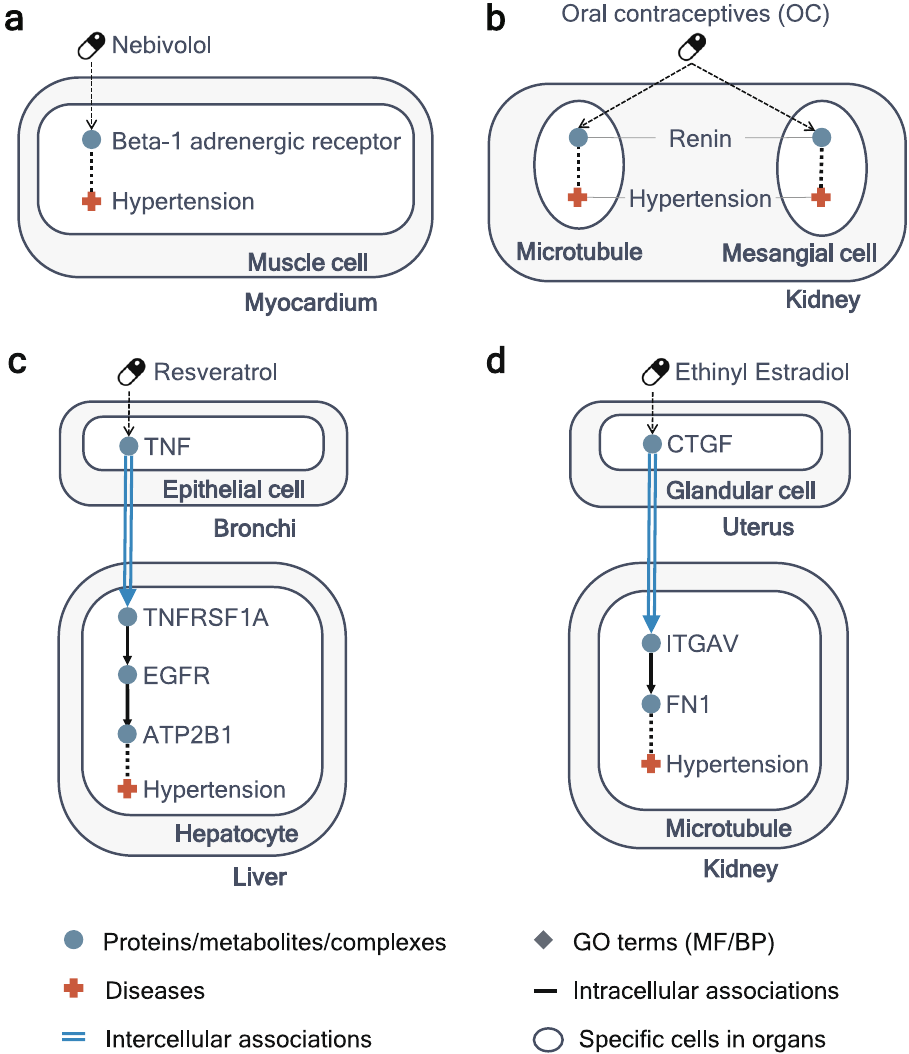
Figure 5. Usefulness of context information for inferring known drug-disease associations. ( a ) Illustration of the path from nebivolol to hypertension in the CODA network. Nebivolol affects beta-1 adrenergic receptor in muscle cell in myocardium and beta-1 adrenergic receptor is associated with hypertension in muscle cell in myocardium. ( b ) The shortest path from Oral contraceptives (OC) to hypertension in CODA. OC affects renin in kidney and renin is associated with hypertension in kidney. ( c ) One of the shortest paths from resveratrol’s targets to hypertension in CODA. Resveratrol has an effect on hypertension through intercellular associations. ( d ) One of the shortest paths from targets of ethinyl estradiol to hypertension. Ethinyl estradiol affects CTGF in glandular cell in uterus, CTGF in glandular cell in uterus affects ITGAV in microtubule in kidney, ITGAV in microtubule in kidney is associated with FN1 in microtubule in kidney, and FN1 in microtubule in kidney is associated with